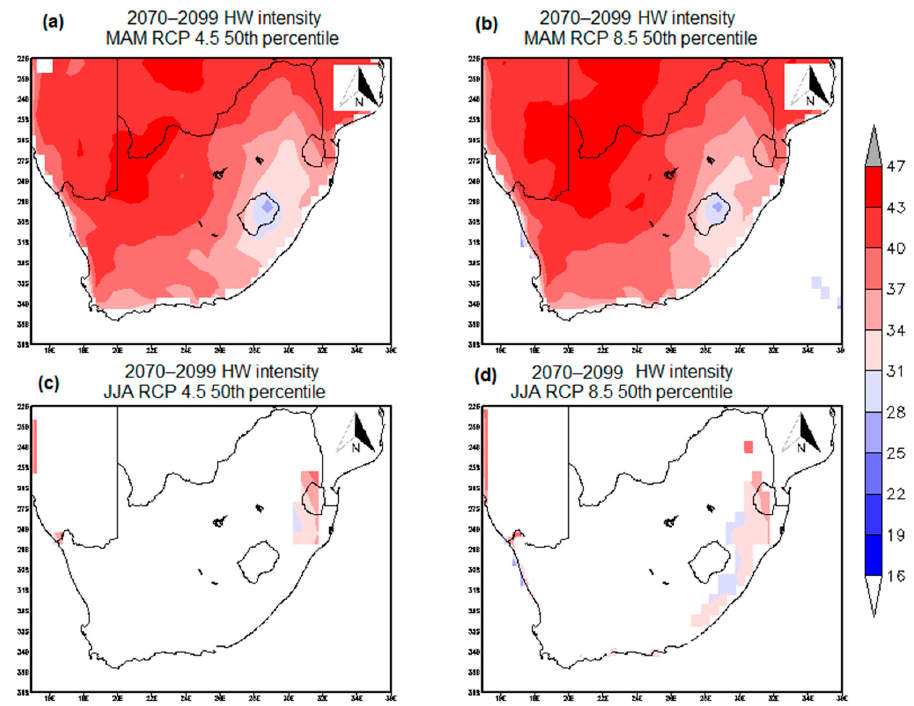
Figure 10. Simulations of HW intensity 50th percentile for ( a ) 2070–2099 MAM RCP 4.5, ( b ) 2070–2099 MAM RCP 8.5, ( c ) 2070–2099 JJA RCP 4.5, and ( d ) 2070–2099 JJA RCP 8.5.